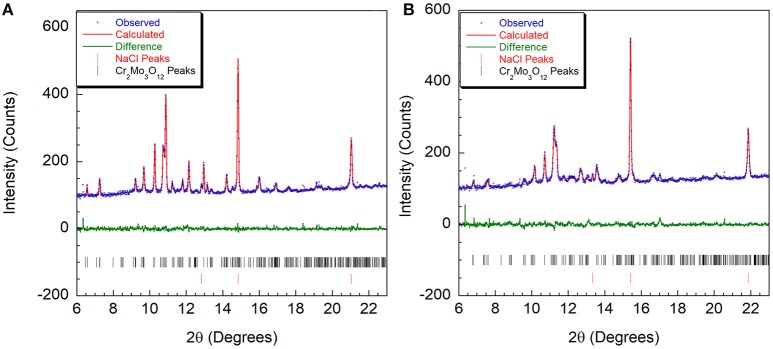
Rietveld plots of Cr2Mo3O12 data collected at (A) 0.05 GPa and (B) 3.7 GPa refined using the P21/a structure.